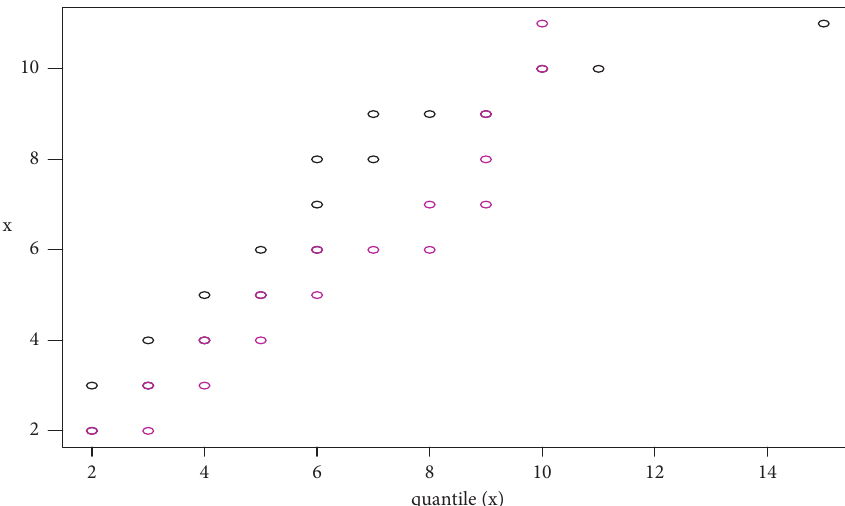
Figure 7: Graphical plots of the data and the quantile function as a function of ( x ), where x is the number of deaths per day.